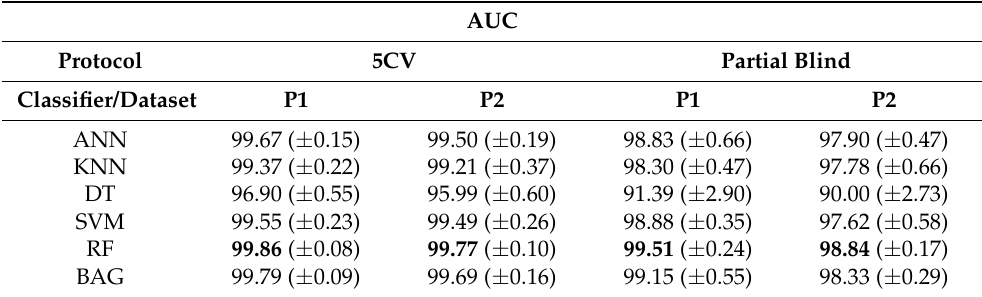
Table 4. AUC results of different classifiers for arrhythmia classification in the two proposed protocols.